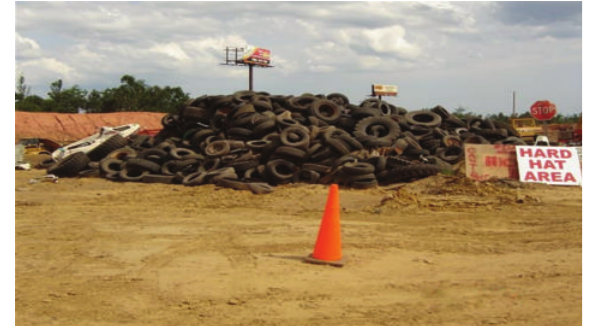
Figure 13: Vessel removed from Pass Christian, MS. Figure 14: Tires segregated at Firestone TDSRS slated for